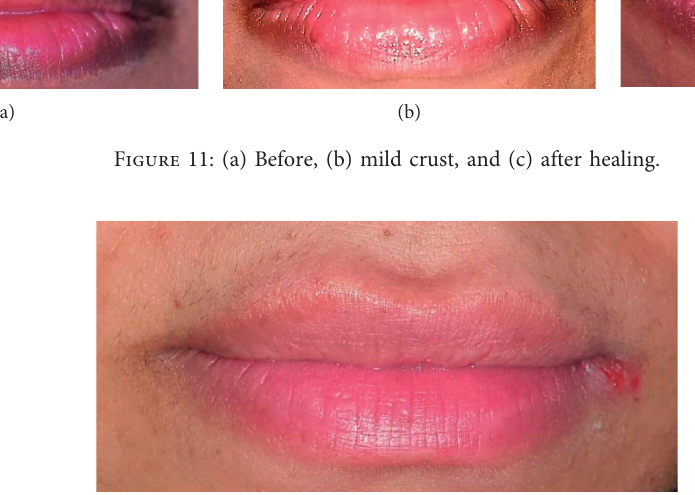
Figure 12: Reactivated herpes labialis.